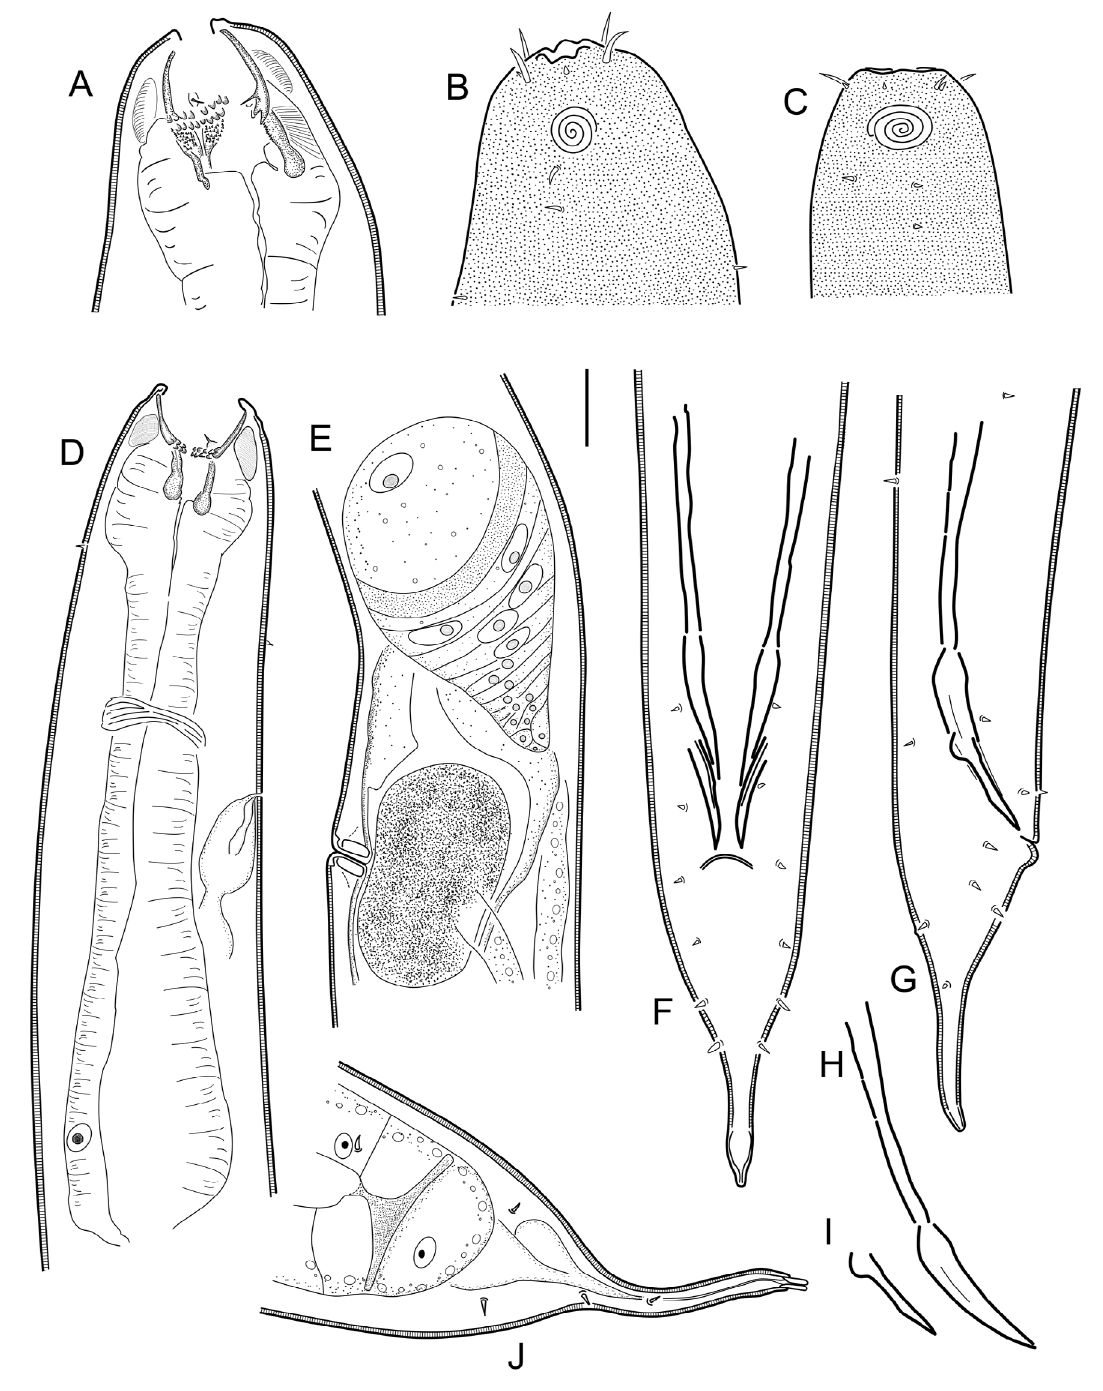
Fig. 4. Cobbionema cylindrolaimoides Schuurmans Stekhoven, 1950. A . Female head region (ventral side to the left) (SMNH-179211). B . Surface view of female head (ventral side to the left) (SMNH- 197211). C . Surface view of male head (ventral side to the right) (SMNH-179212). D . Anterior part of male (ventral side to the right) (SMNH-179212). E . Female mid body region showing anterior branch of the reproductive system and an egg (SMNH-179211). F . Dorsoventral view of spicules (SMNH- 179213). G . Lateral view of spicules (SMNH-179214). H . Spicule. I . Crura. J . Female tail (SMNH- 179211). Scale bar = 20